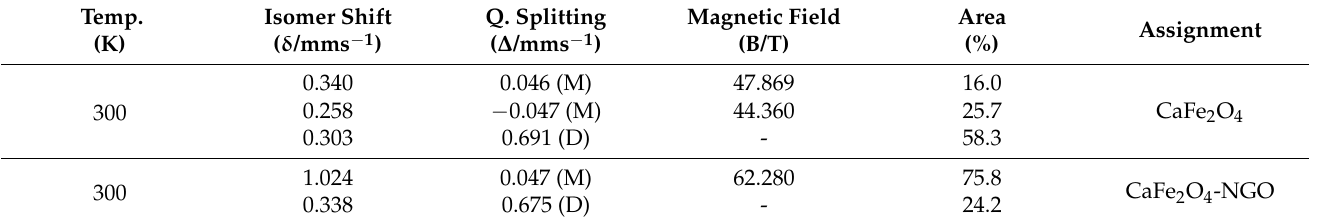
Table 2. Mossbauer parameters for CaFe 2 O 4 and CaFe 2 O 4 -NGO.